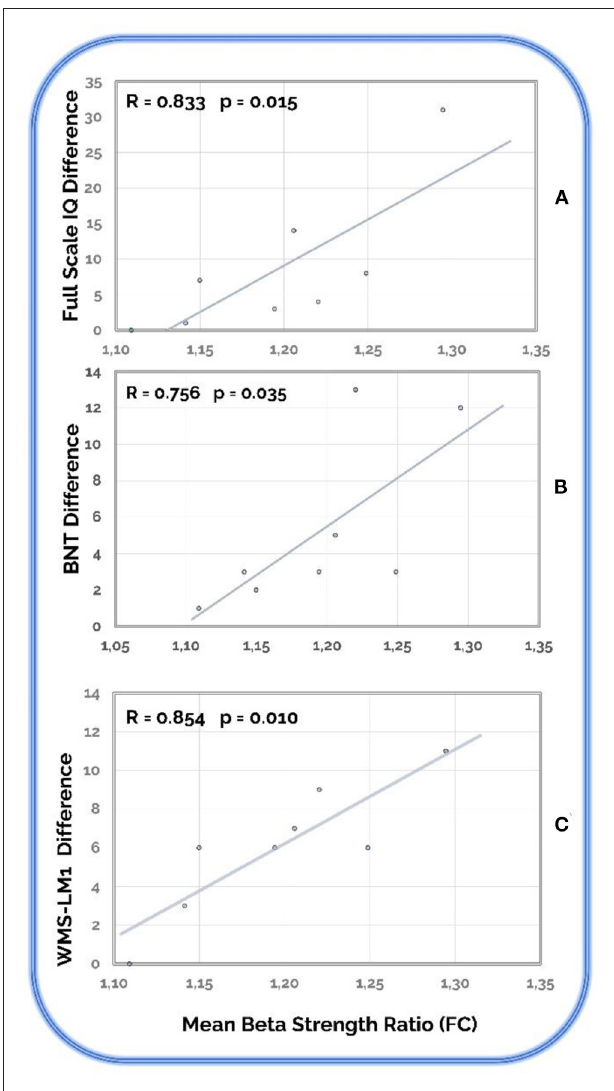
FIGURE 5 | Recovery signatures correlations. Statistically significant correlations between cognitive differences and the mean beta strength ratio in the stroke patients’ group. (A) Full Scale IQ (of WAIS-III); (B) BNT (Boston Naming Test); (C) WMS-LM1 (Logical Memory 1 of